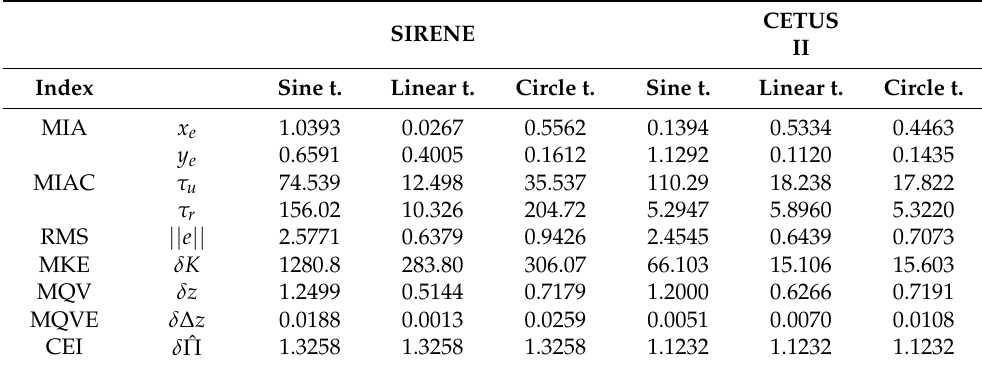
Table 2. Performance for the SIRENE and CETUS II.